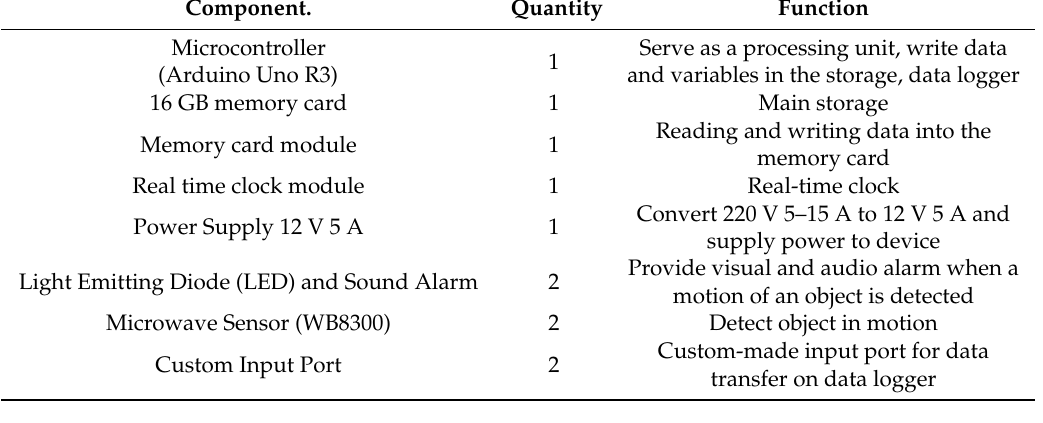
Table 1. System components.